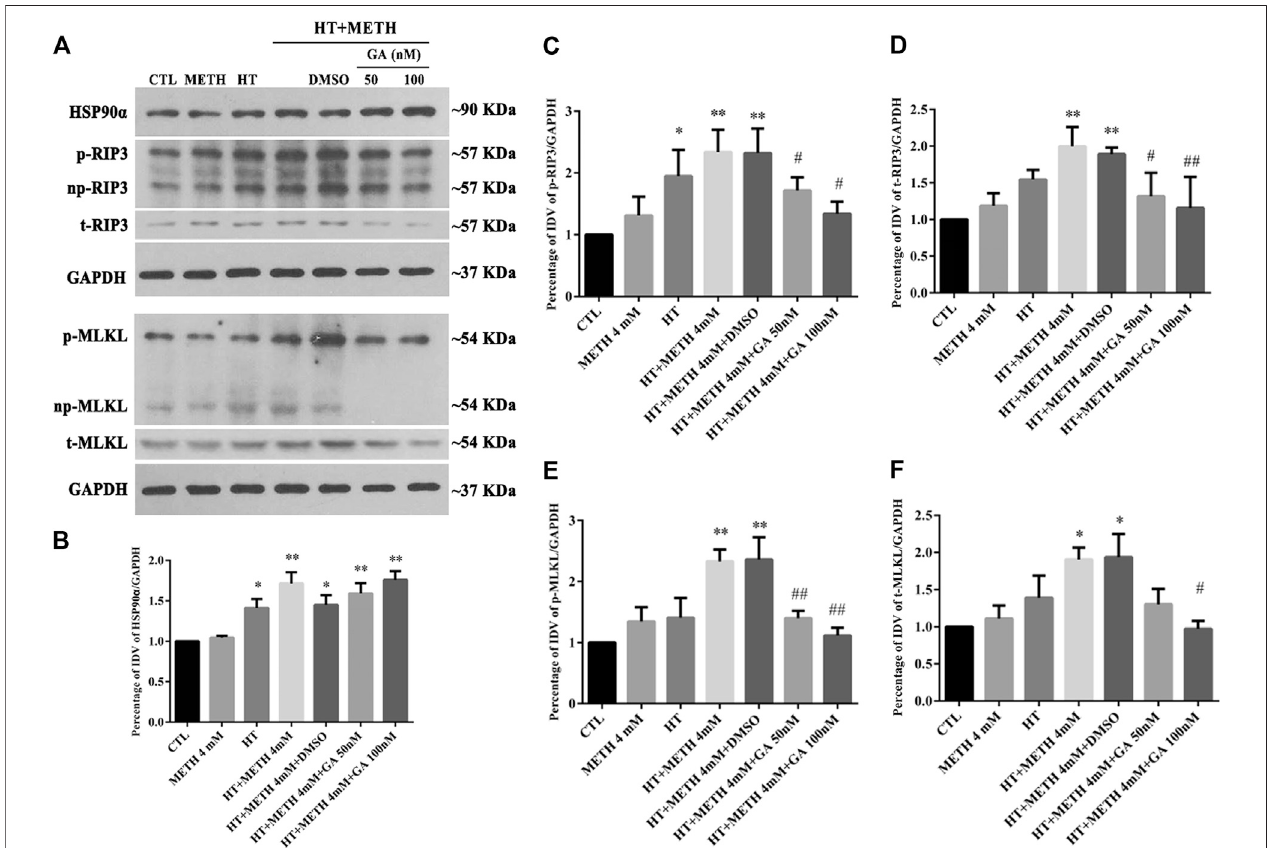
FIGURE 5 | Detection of HSP90 α , RIP3, p-RIP3, MLKL, and p -MLKL in striatal neurons following METH/HT injury and pre-treatment with GA. (A) WB of HSP90 α , RIP3, p-RIP3, MLKL, and p-MLKL after treatment with METH/HT for 6 h and pre-treatment with 50 and 100 nM GA. (B – F) Statistical analysis of WB of HSP90 α , RIP3, p-RIP3, MLKL, and p-MLKL expression. Data were analyzed by one-way ANOVA, followed by a Tukey multiple comparisons posttest ( n (cid:2) 3). * p < 0.05, ** p < 0.01 vs. CTL group; # p < 0.05, ## p < 0.01 vs. HT + METH 4 mM group.